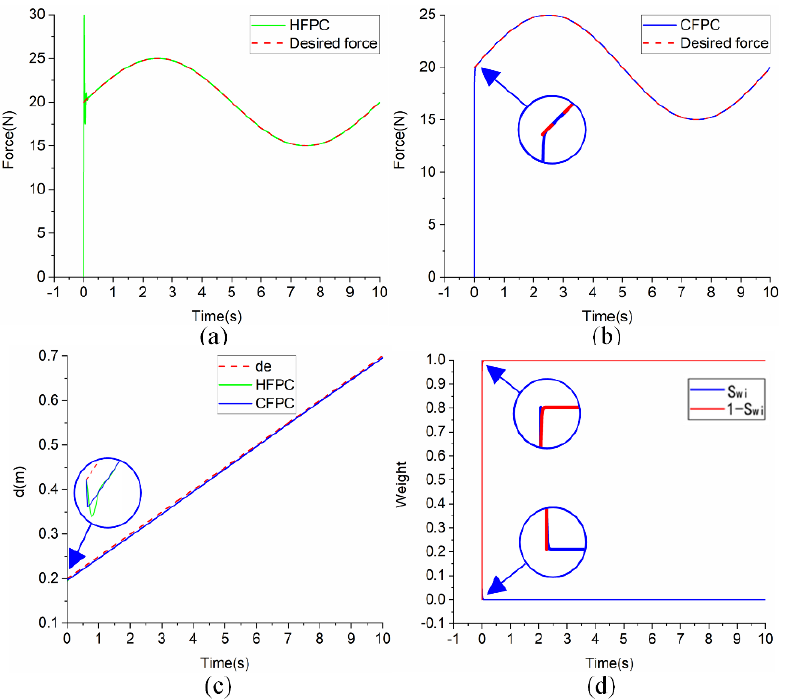
Figure 5. Simulations on sloped surface. Force tracking using ( a ) the HFPC and ( b ) proposed CFPC methods. ( c ) Position tracking. ( d ) Weighted parameter wi s .